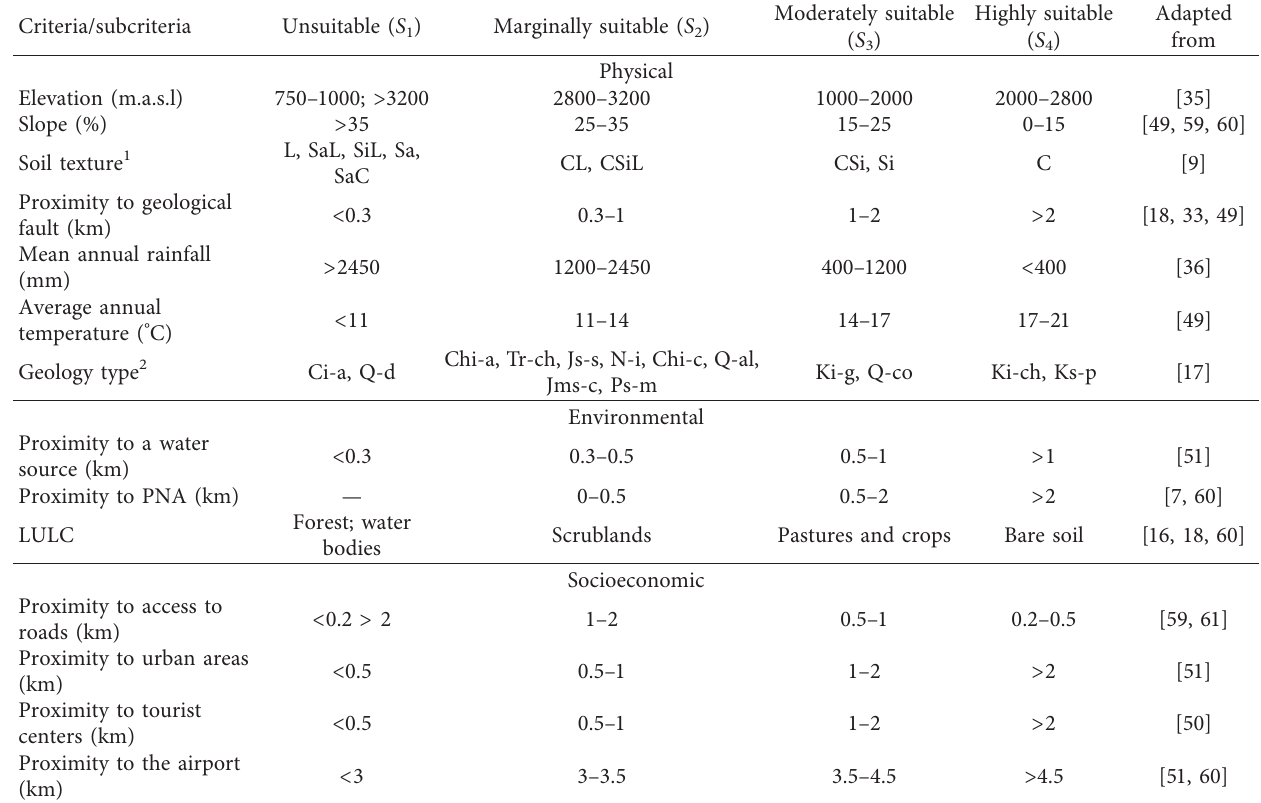
Table 1: Suitability thresholds of the subcriteria to model the suitability of areas in the territory of Chachapoyas and Huancas (NW Peru) for landfills.